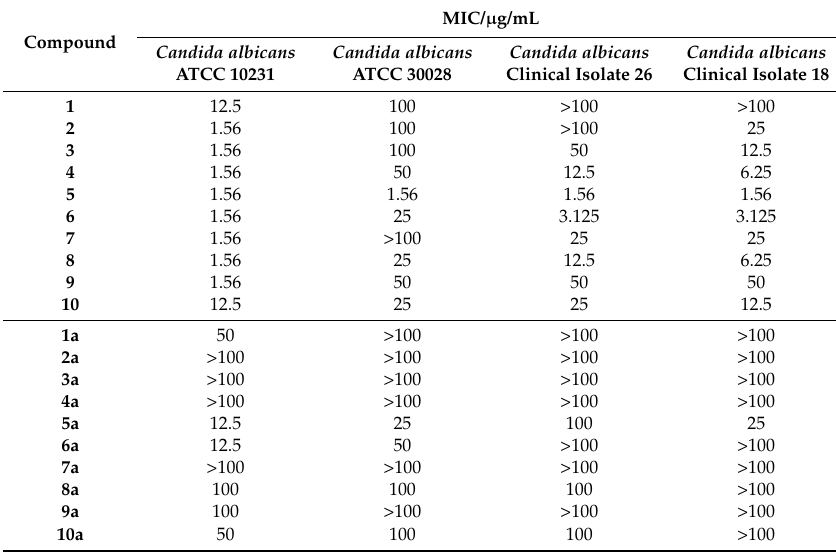
Table 1. Antifungal activity against Candida albicans stains (MIC values in µ g/mL).